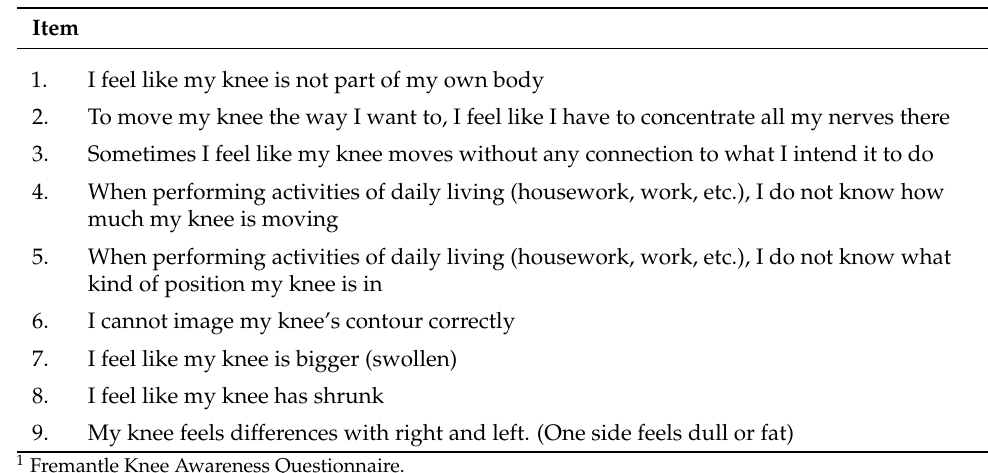
Table 1. Items of the FreKAQ 1